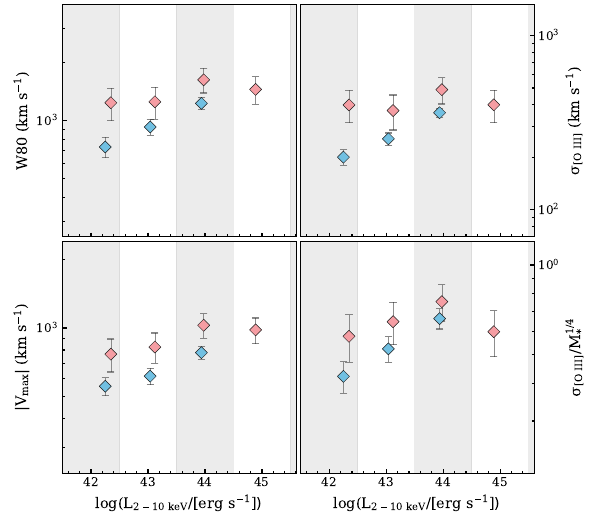
Figure 8. Same as Figure 7, but L 2 – 10keV is in bins of 1 dex. Diamonds present the mean values in each bin for each sample. The error bars show the Root-Mean-Square error (RMSE) in each